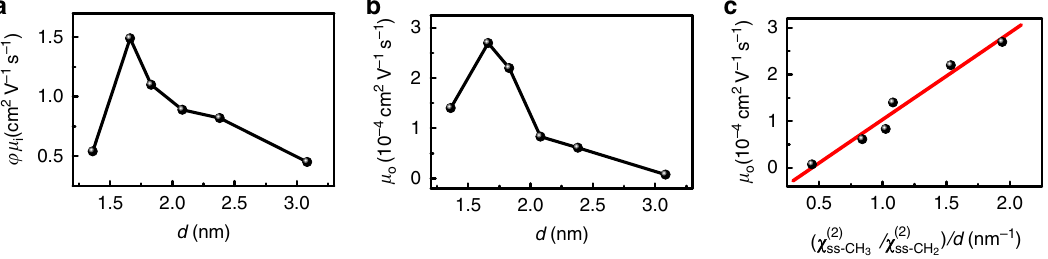
= χ 2 ð Þ Þ = d . a The effective in-plane mobility versus ss (cid:2) CH 2 CH 3 = χ 2 ð Þ Þ = d ss (cid:2) CH 2 CH 3